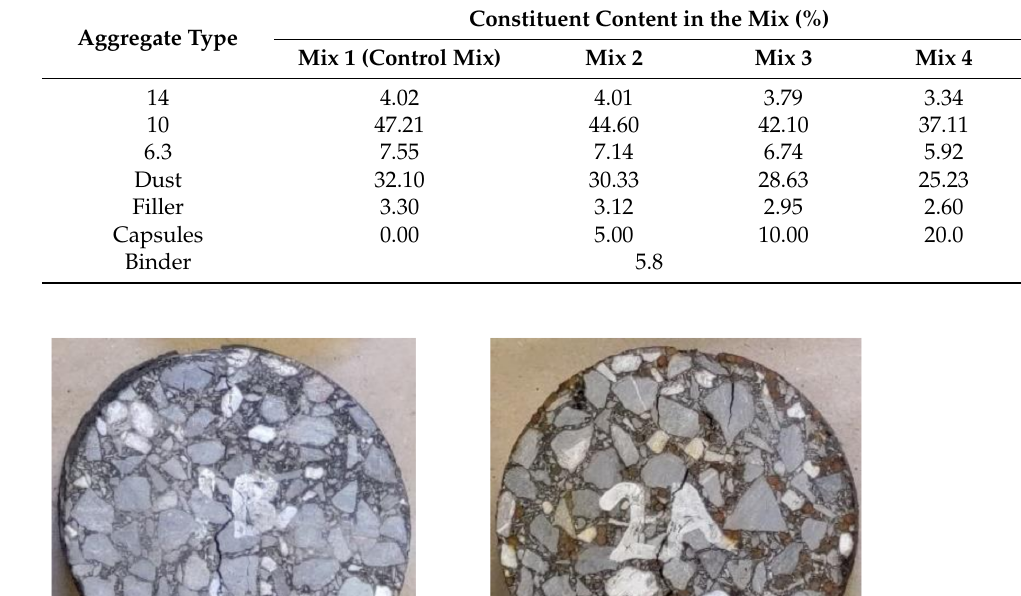
Table 3. The 10 mm SMA mix designs.